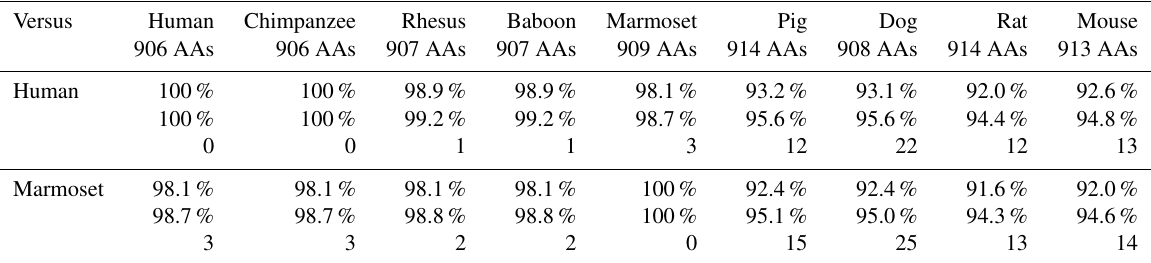
Figure 4. Immunofluorescence analysis of c-CBL in differentiated iPS cells in feeder-free conditions. The marmoset iPS cells were differen- tiated in plates coated with Geltrex matrix in M10 medium for 2 days (b) or kept undifferentiated in Essential 8 medium. The differentiation- associated changes in morphology (bright field image in the lower panel) are associated with decreased c-CBL and NANOG signal intensities compared to the control condition (a) . Table 1. Amino acid (AA) sequence comparison of c-CBL of different primate and non-primate species. The number below each species indicates the number of AA residues of the protein. The upmost number in each box gives the percent identity and the middle number the percent similarity. The lowest number gives the number of gaps in each comparison. Versus Human Chimpanzee